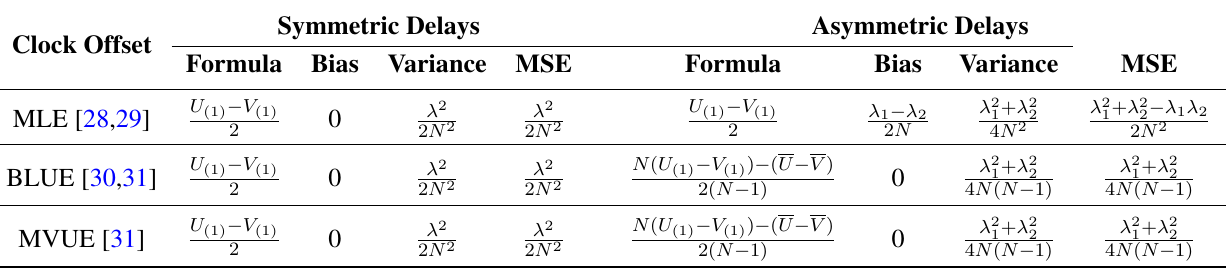
Table 1. Comparison of